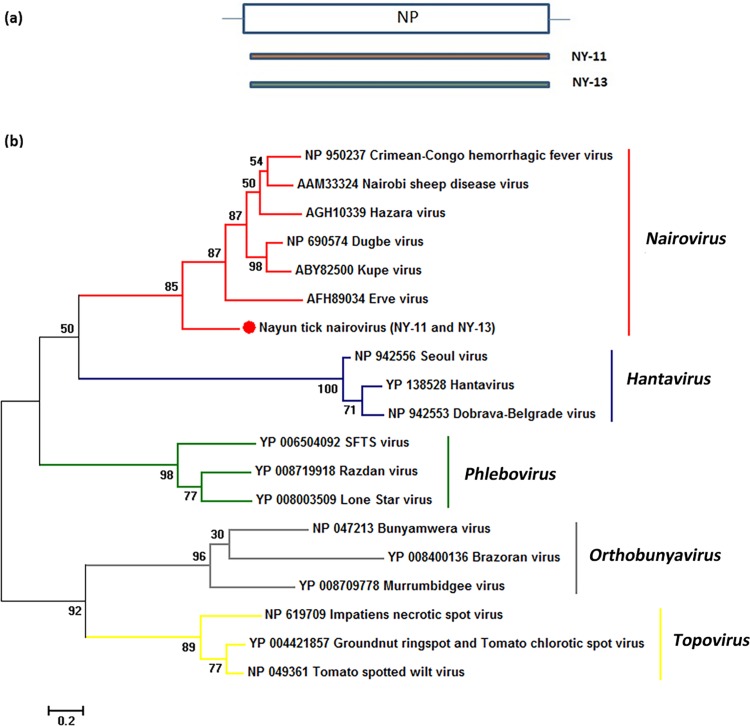
Phylogenetic analysis of nairovirus-related sequences from ticks.(a) Schematic representation of the S segment encoded nucleoprotein (∼480 amino acids) of Nairovirus. The orange and green bars represent the contig sequences from NY-11 and NY-13. (b) Phylogenetic analysis of the selected contigs related to Nairovirus is based on alignments with 480 amino acids of the nucleoprotein. All five Bunyaviridae genera are indicated on the right of the tree. NP denotes nucleoprotein.